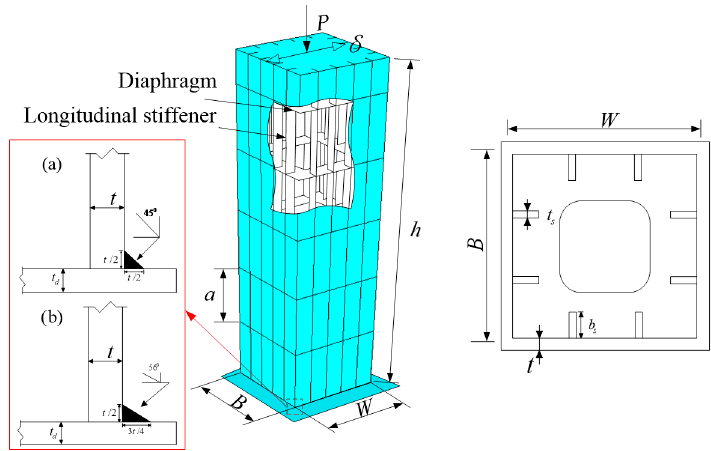
Figure 14. Schematic diagram of single-column steel bridge pier. Table 7. Geometric dimensions of steel bridge piers.